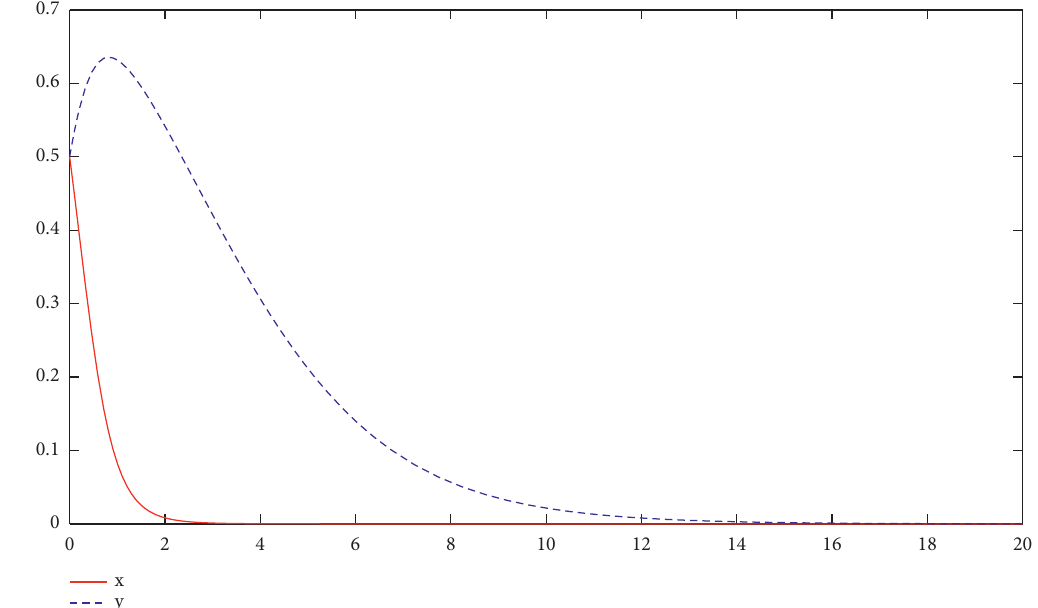
Figure 5: The evolution track of scenario